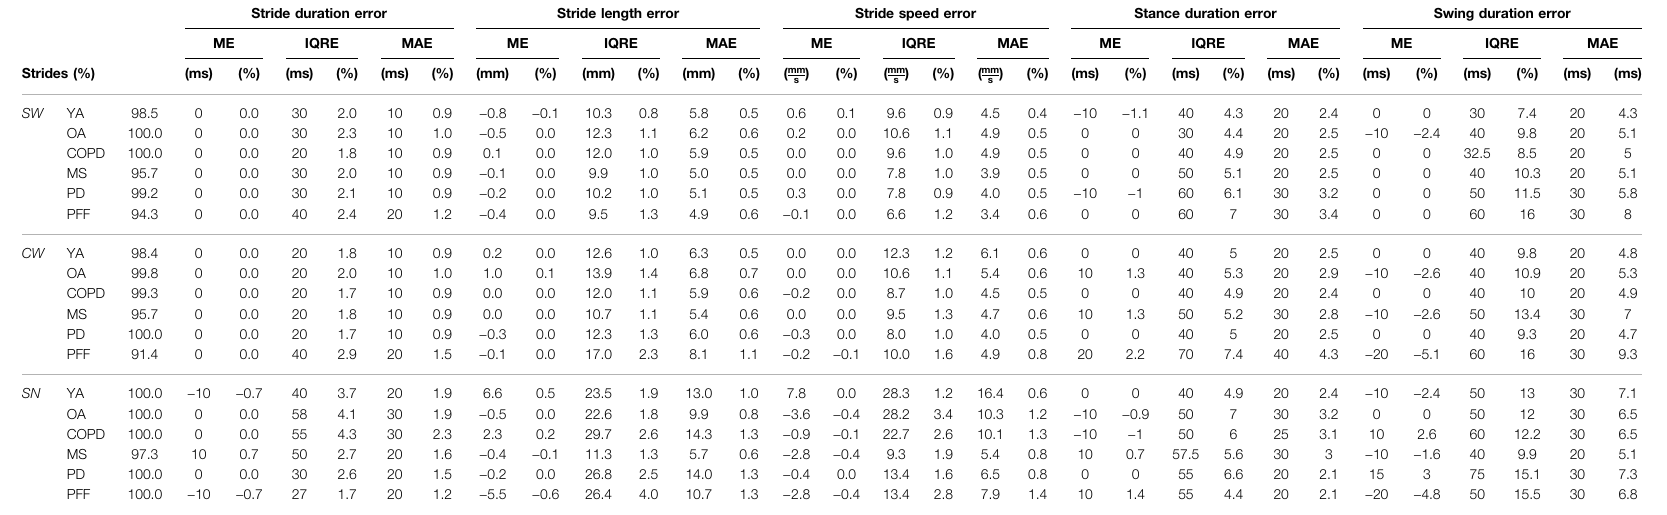
TABLE 4 | Correctly detected strides (%) for each cohort (young adults (YA), older adults (OA), multiple sclerosis (MS), Parkinson disease (PD), chronic obstructive pulmonary disease (COPD); and proximal femur fracture (PFF) and walking conditions (straight-line walking, SW ; curvilinear walking, CW ; and step negotiation, SN ) are reported. The errors in the relevant stride duration (ms), length (mm), speed (mm/s), and stance/swing durations (ms) are described in terms of median (ME, i.e., bias), inter-quartile range (IQRE, i.e., precision), and median absolute errors (MAE, i.e., accuracy); relative errors (%) are also